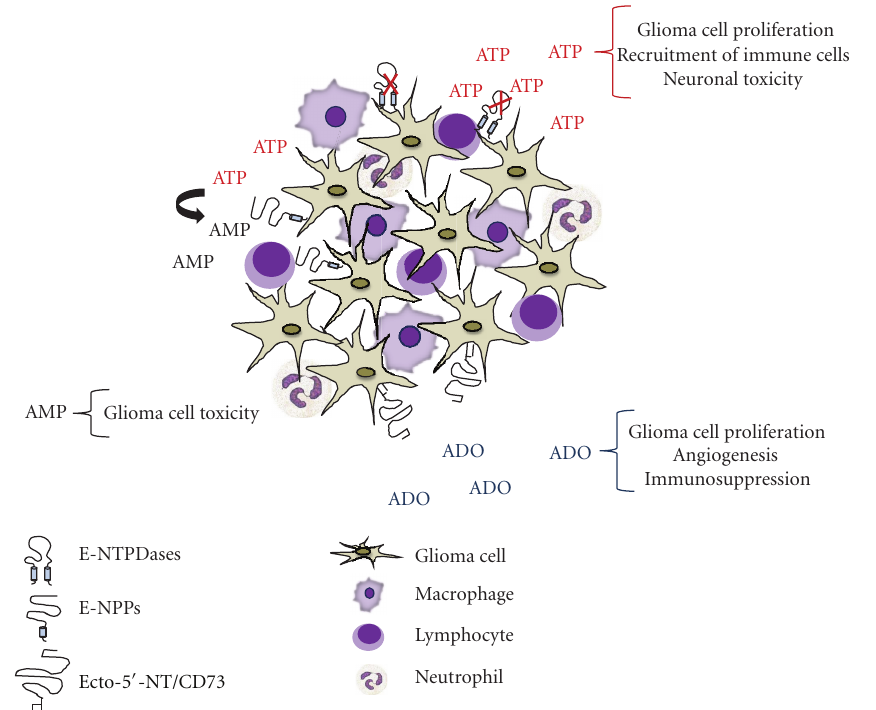
Figure 1: Ectonucleotidases in glioma progression. Glioma cells exhibit low ATP/ADP hydrolysis and a high AMP hydrolysis activity [91]. The inversion of extracellular nucleotide metabolism may favor extracellular ATP and adenosine accumulation within the tumor [51, 52, 66]. ATP could induce neuronal toxicity [90], glioma cell proliferation [88], and recruitment of immune cells by inducing the release of proinflammatory factors by tumor cells, such as MCP-1 and IL-8 [99]. Upon reaching the tumor, di ff erent stimuli modulate macrophage to M2 phenotype [100, 101], and studies from our laboratory showed that ectonucleotidases are involved in the di ff erentiation of macrophages [24]. The glioma cells exhibit NPP1 on the plasma membrane [94]; this enzyme generates AMP that is toxic for gliomas [74] but is the substrate for the ecto-5 (cid:2) -NT/CD73 which is highly expressed in glioma [74]. Ado, product of AMP hydrolysis could induce tumor cell proliferation, angiogenesis, and immunosuppression [56]. Therefore, the ATP and its hydrolytic products could be closely related to the immune responses involved in the glioma